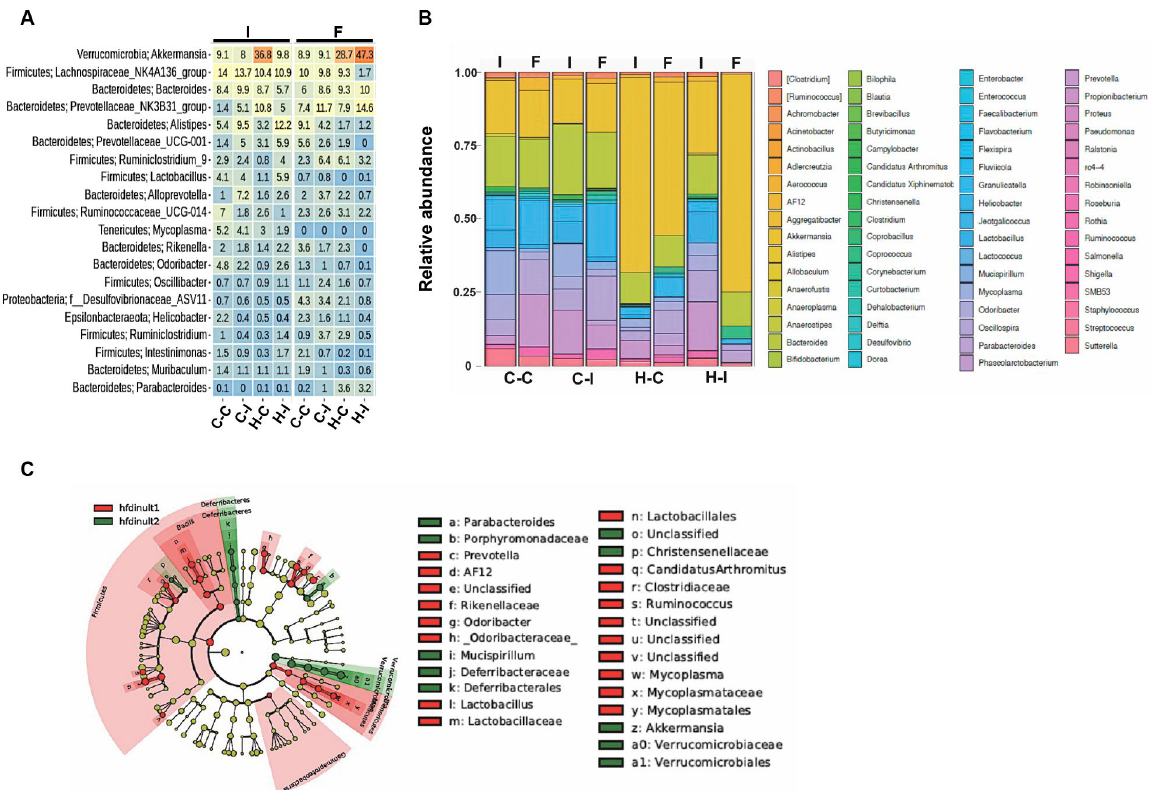
Figure 5. Representative features identified in the H-I mice group at the beginning (I) or end (F) of the inulin supplementation. ( A ) Fold change at the genus level in the four different mice groups. Numbers indicate percentage changes in each case respect its time counterpart and rows correspond to the genus associated. The genus level is plotted as the relative abundance in the four mice groups ( B ) or as the taxonomic differences focusing on the H-I group ( C ).